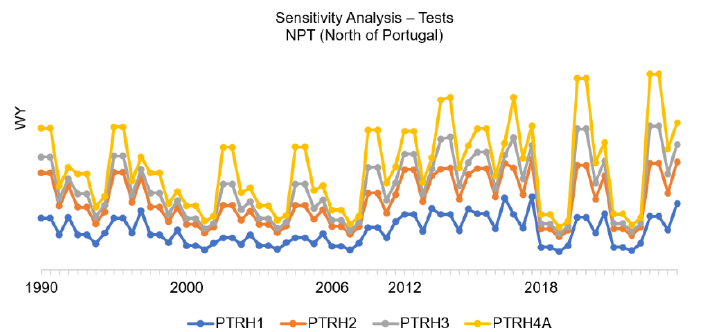
Figure 10. Sensitivity analysis tests by river basin district (RBD) of the North of Portugal.